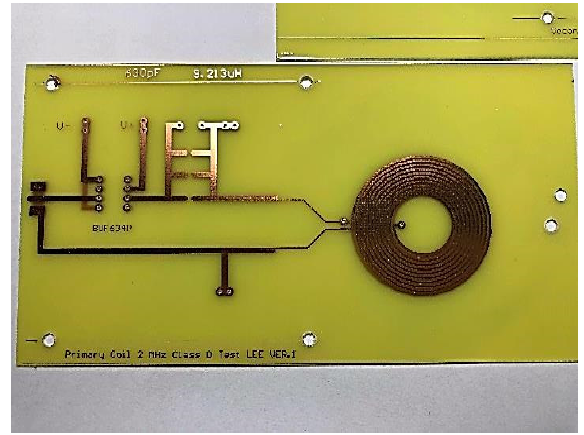
Figure 24. Primary measurement resonance coil.